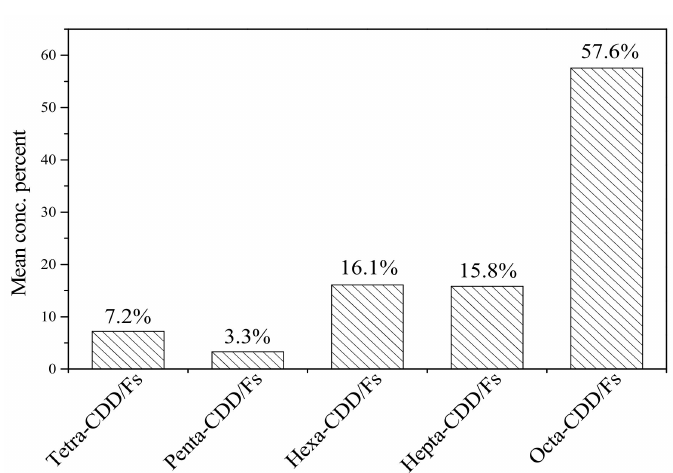
Figure 1. PCDD / F congener profiles in cord serum samples.